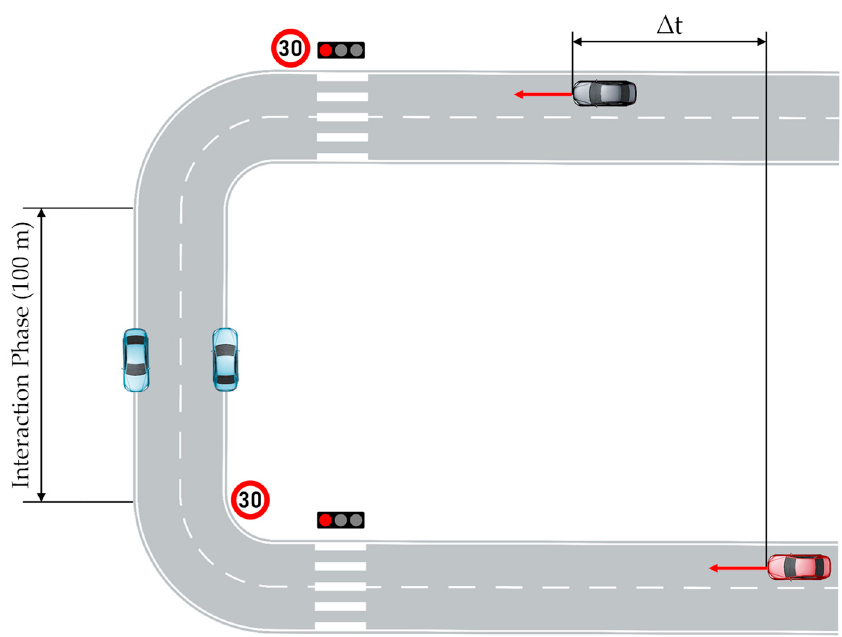
Figure 1. Basic synchronization of the AV (red vehicle in the lower part) and human driver (black vehicle in the upper part) via the traffic light control. The route does not correspond to the real course in the simulation and is shown schematically.